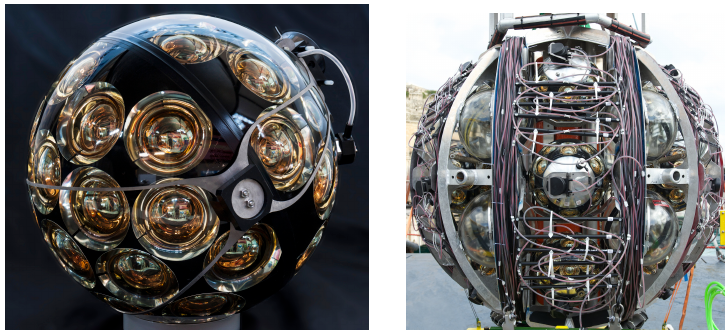
Figure 2: Left: a picture of a completed KM3NeT multi-PMT DOM. Right: a fully assembled KM3NeT string ready for deployment, wound up on a deployment